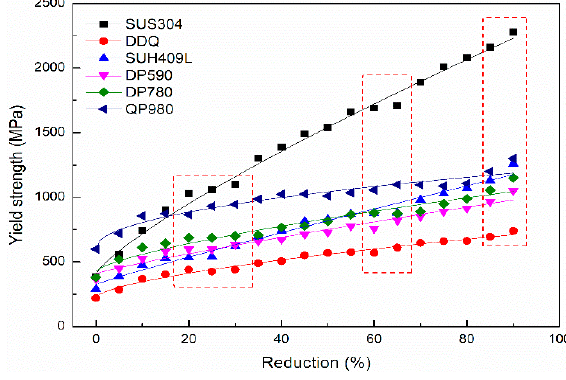
Figure 2. Deformation resistance curve of typical steel grades.